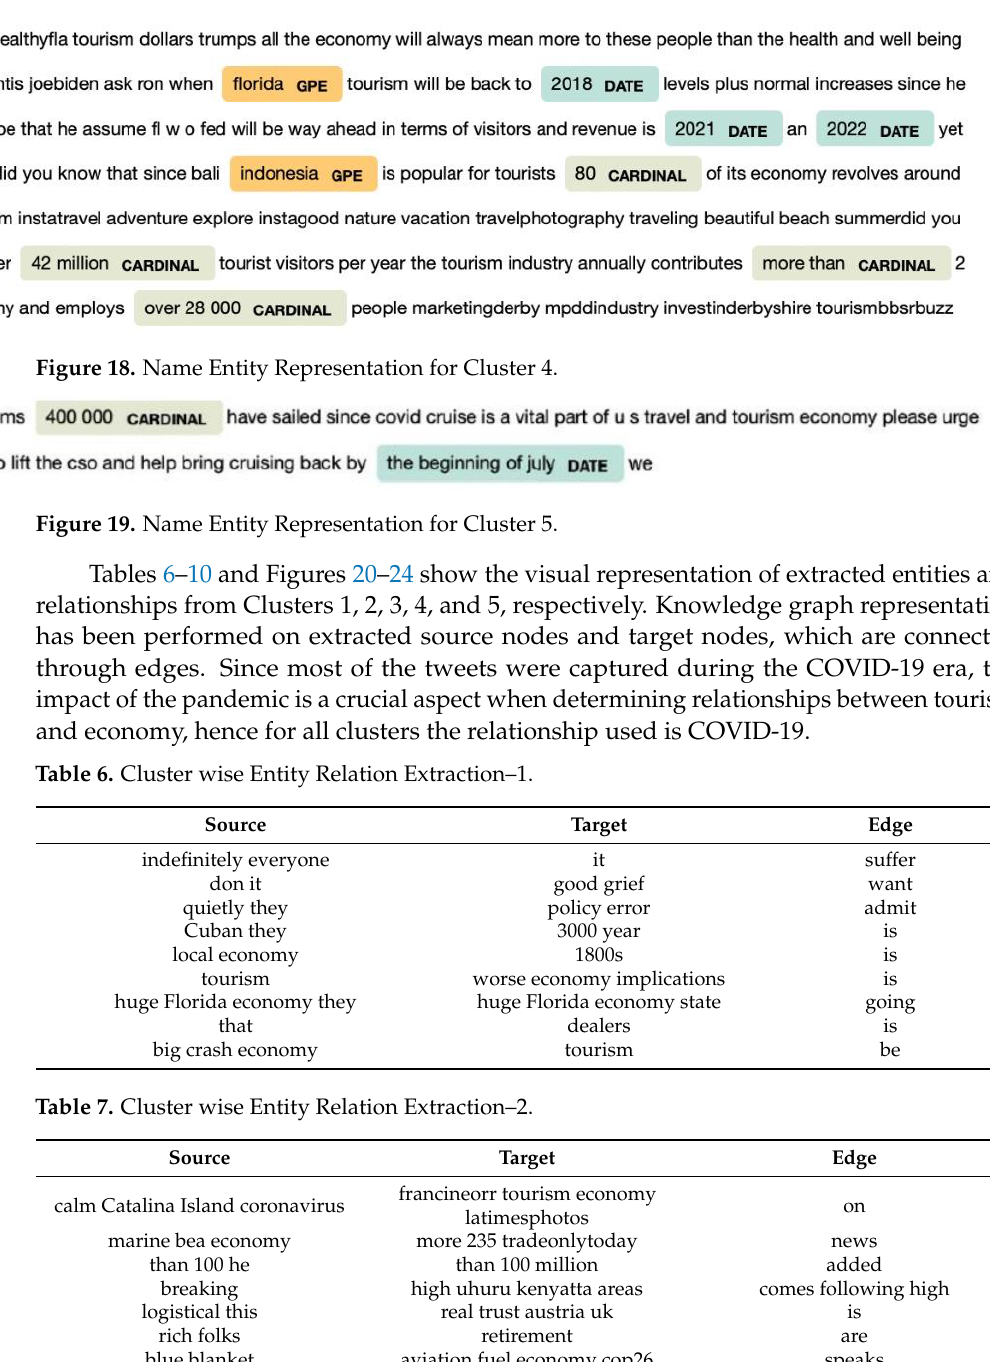
Figure 18. Name Entity Representation for Cluster 4.